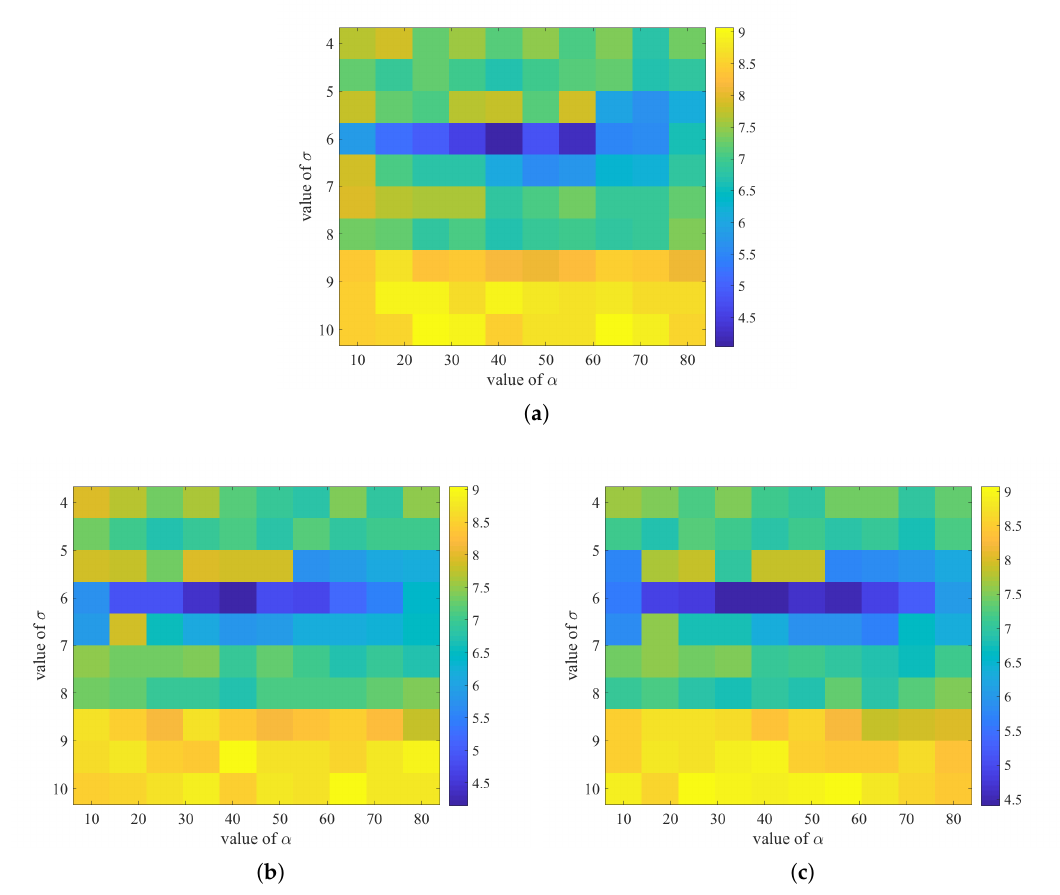
Figure 7. Two-dimensional grid search for the hyperparameters α and σ for Wi-Fi based fingerprinting if ( a ) grid length is 1 m; ( b ) grid length is 1.5 m; ( c ) grid length is 2